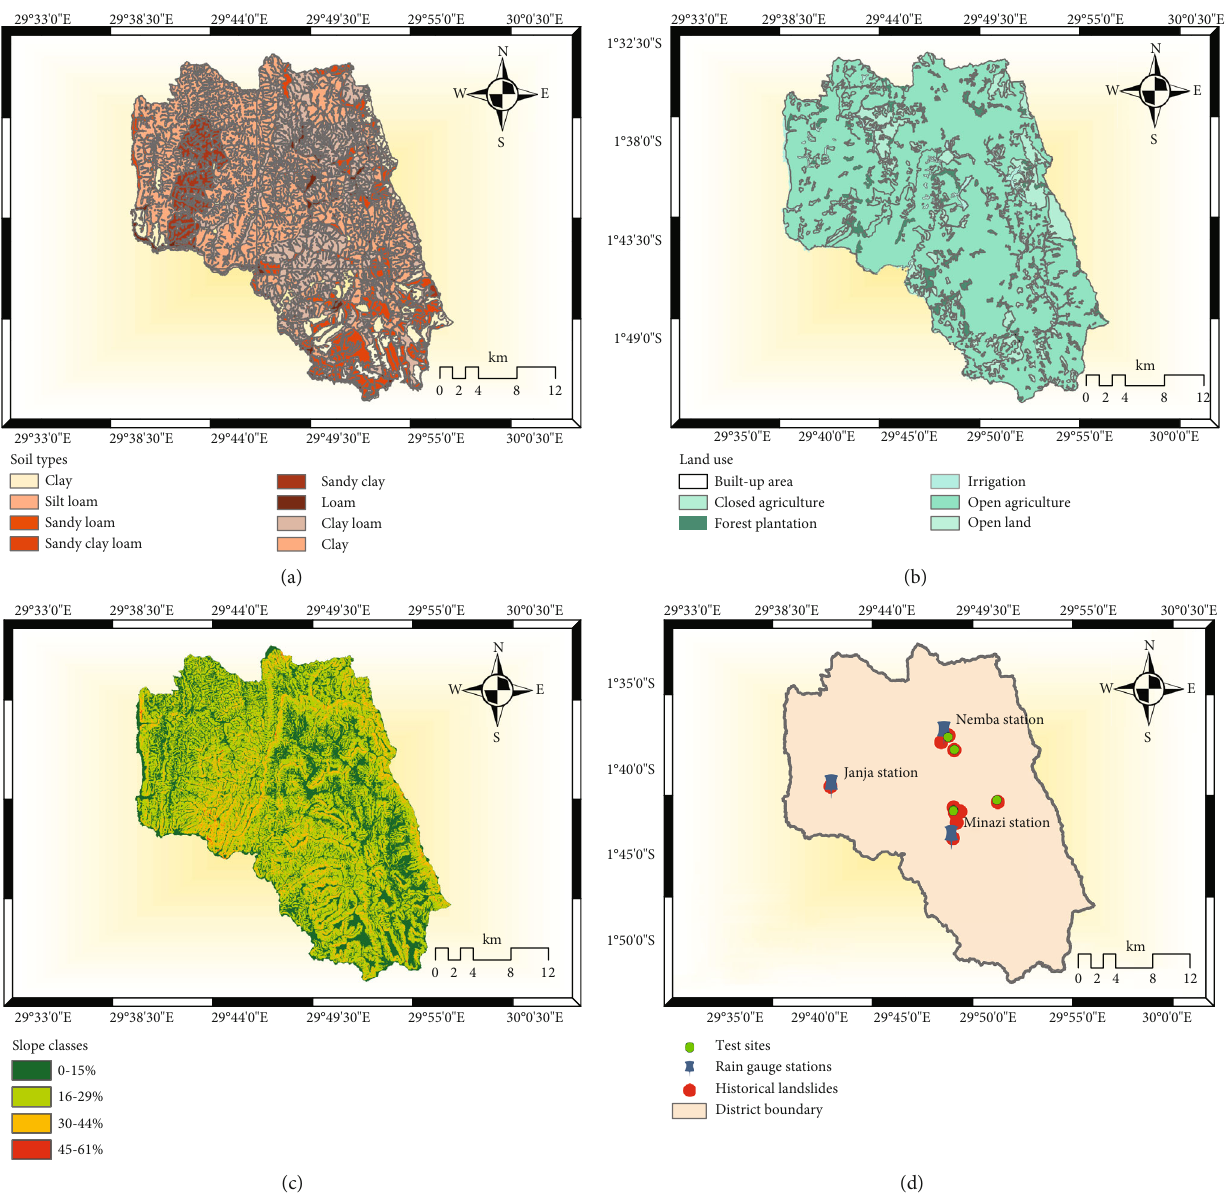
Figure 3: Maps: (a) soil types, (b) land use classi fi cation, (c) slope classi fi cation, and (d) rain gauge and test site